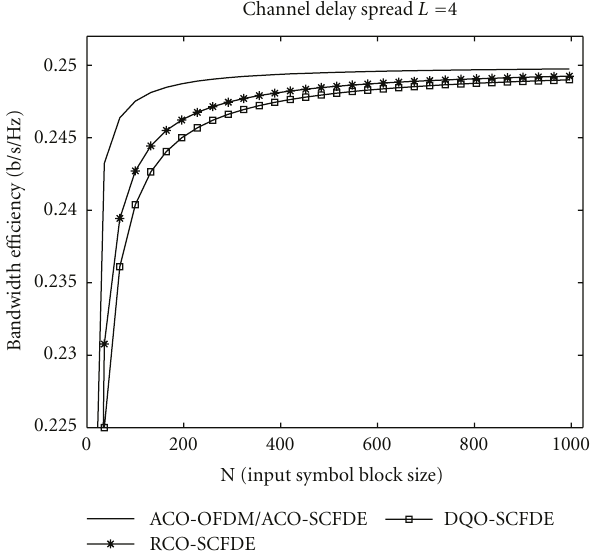
Figure 9: Bandwidth e ffi ciency comparison for ACO-OFDM, ACO-SCFDE, RCO-SCFDE, and DQO-SCFDE with channel delay spread of L = 4 sampling times.